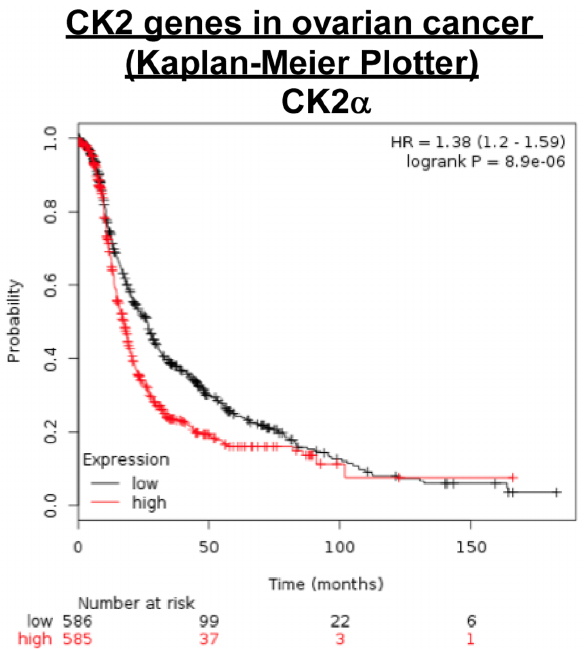
Fig. 8. CK2 genes in ovarian cancer (Kaplan-Meier Plotter). Kaplan-Meier plots showing overall survival in ovarian cancer. In red: patients with expression above the median and in black, patients with expressions below the median. The CK2 genes and corresponding p-values are listed. CK2 a , p 5 8.9 10 2 6 ; CK2 a P, p 5 0.034; CK2 a ’, p 5 0.45; CK2 b , p 5 0.12.